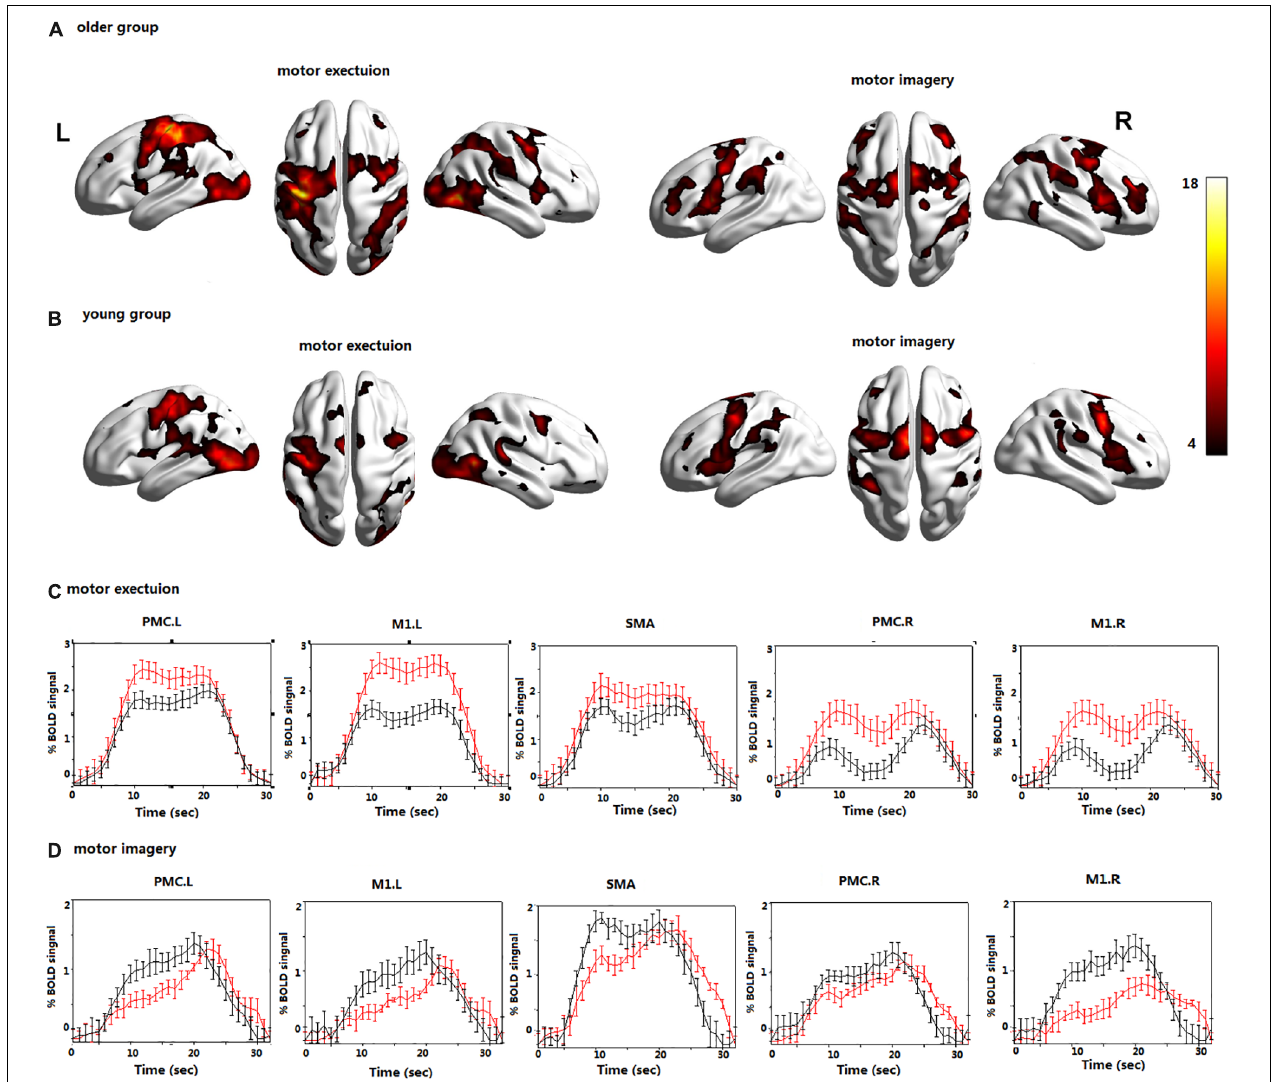
FIGURE 2 | The brain activations during motor execution (ME) and motor imagery (MI) in (A) the older group; (B) the young group; the BOLD signals averaged across trials and subjects and presented as the mean ± standard error for the older (red) and young group (black) during (C) ME; (D) MI; all voxels are significant at P < 0.01. FDR corrected for the whole brain. Left premotor cortex (PMC.L); right premotor cortex (PMC.R); supplementary motor area (SMA); left primary motor cortex (M1.L); and right primary motor cortex